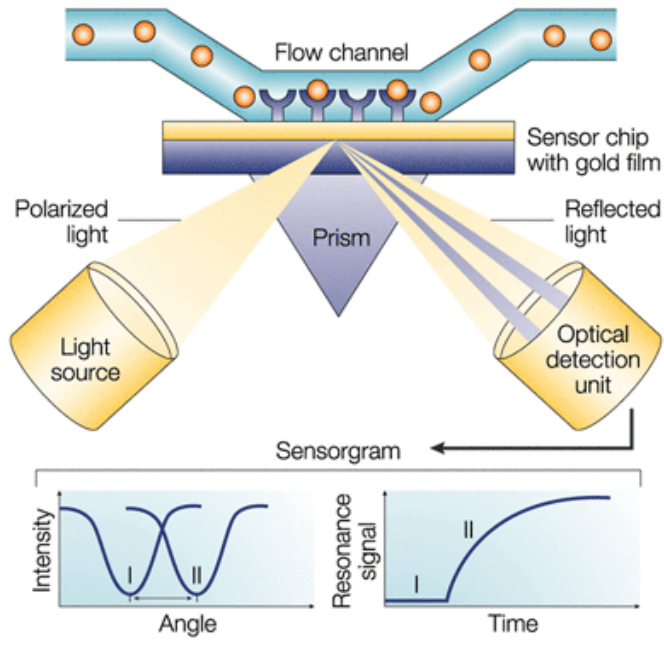
Figure 1. A schematic of the conventional Kretschmann optical configuration for SPR biosensing and the associated angle shift and sensorgram plot of resonance signal change with time [2]. Reprinted by permission from Macmillan Publishers Ltd: Nat. Rev. Drug Discov. 2002 , 1 , 515-528 copyright 2002;